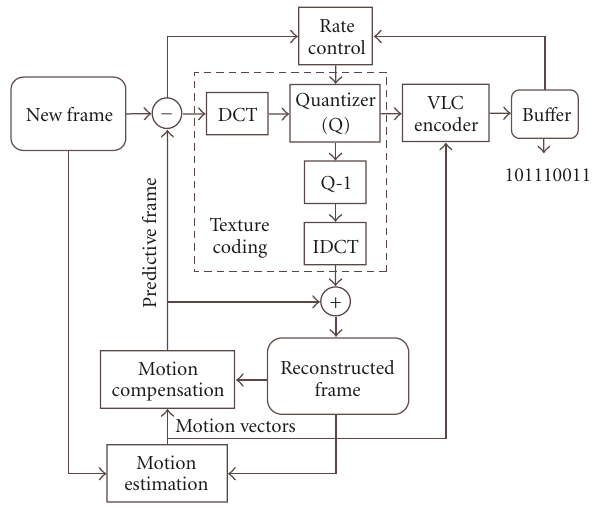
Figure 7: Functional view of an MPEG-4 video